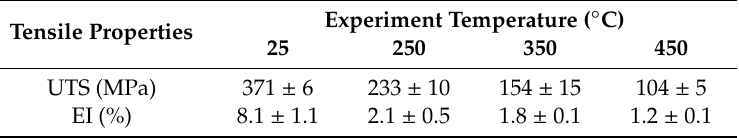
Table 2. Comparison of the tensile properties of several composites.